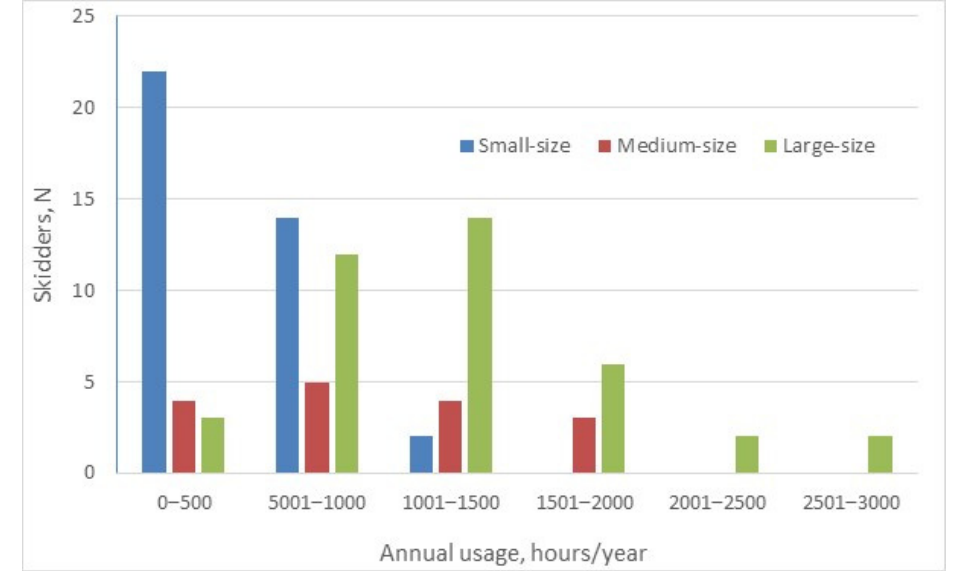
Figure 1. Annual use (machine hours per year) of skidders by size class.